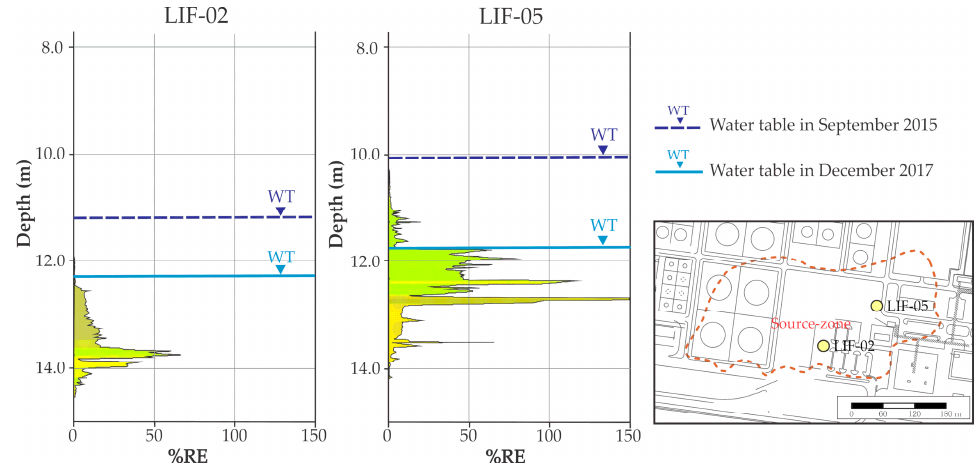
Figure 2. Two laser-induced fluorescence profiles presented by Isler et al. [21], showing LNAPL completely entrapped below the water table. The location of the tests is shown in the right-side panel. As demonstrated by Teramoto and Chang [15], the concentrations of BTEX in the aqueous phase are directly related to the concentrations in the LNAPL. Teramoto and Chang [15] demonstrated that the decline of the BTEX concentration occurs slowly in the case of high LNAPL saturation (the center of the LNAPL source zone) within the pore system and occurs rapidly in the case of low LNAPL saturation (borders of the LNAPL source zone). Thus, the BTEX concentration in the LNAPL will reduce slowly in the center of the LNAPL source zone. Figures 3 and 4 exhibit the ethylbenzene and toluene concentrations, respectively, in the LNAPL. These figures demonstrate that the high concentration is observed in the center of the LNAPL source zone and declines towards the borders.